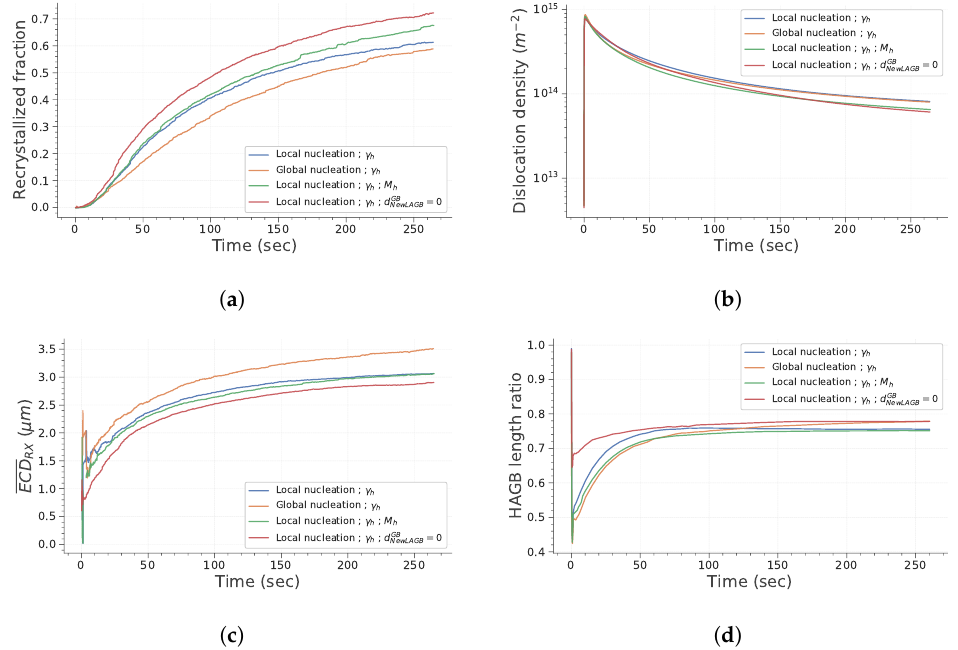
Figure 12. Main microstructural features’ evolution with time. ( a ) Recrystallized surface fraction. ( b ) GND density. ( c ) Mean recrystallized grain size. ( d ) HAGB length